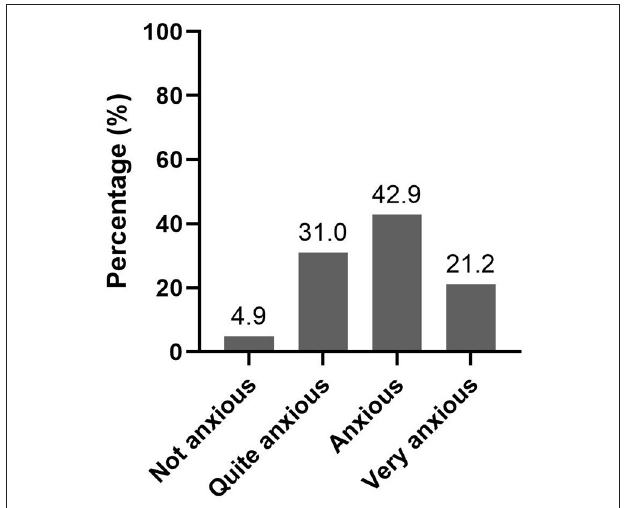
FIGURE 1 | Level of anxiety toward COVID-19 in Indonesia ( n =